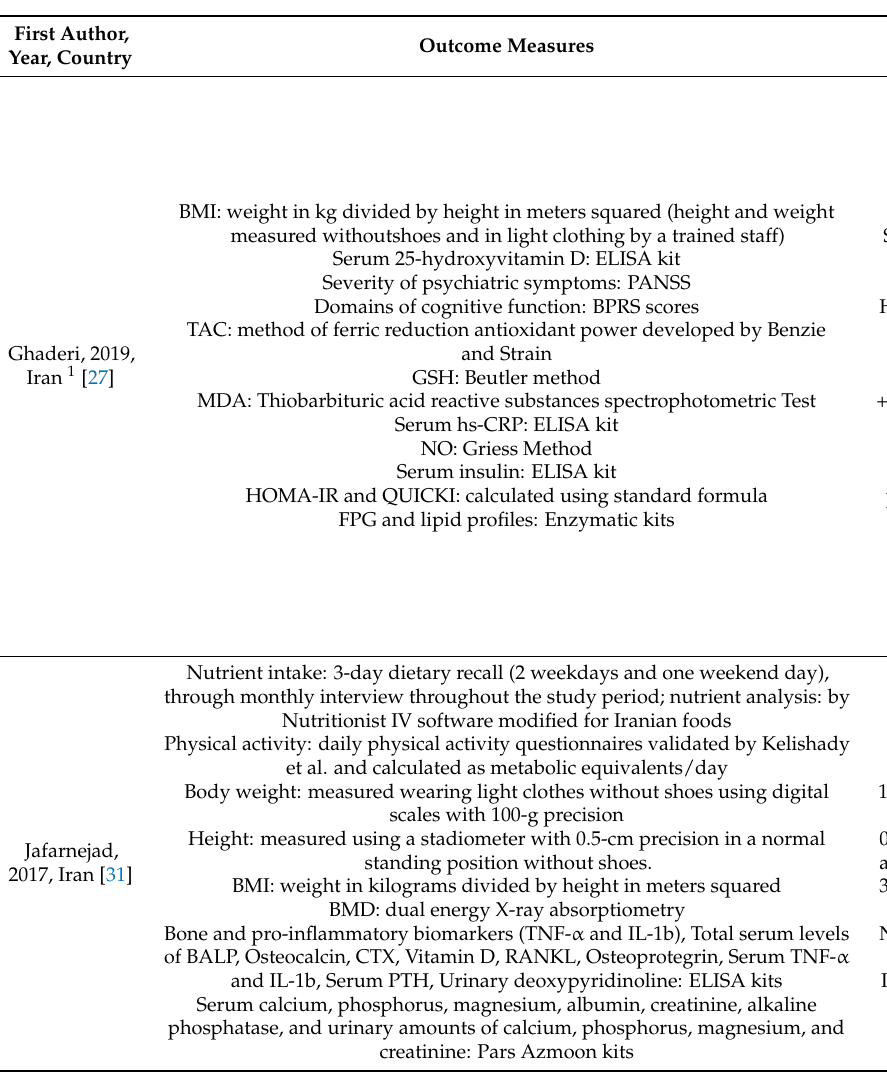
Table 3. Outcomes and results of included